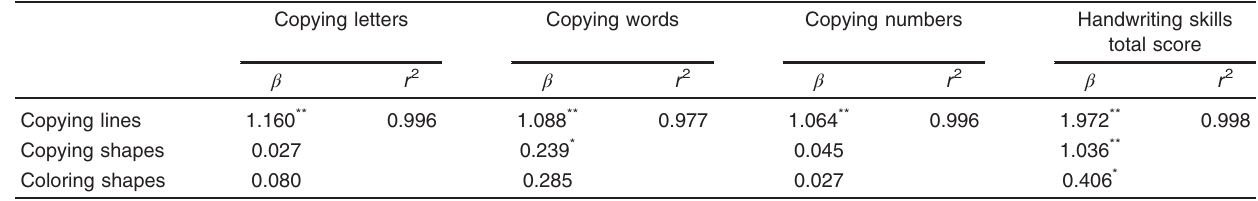
Table 6 Linear regression for the relationship between visual – motor integration and handwriting